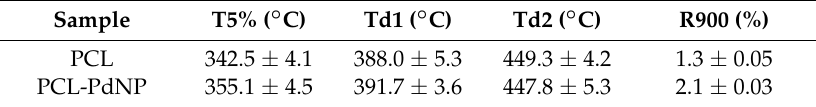
Figure 6. Thermogravimetric analysis (TGA) curves of the electrospun PCL ( left ) and PCL-containing palladium nanoparticles (PdNPs) fibers ( right ). Table 2. Values of thermal stability obtained from the thermogravimetric analysis (TGA) curves of the electrospun PCL and PCL/PdNP electrospun fibers in terms of degradation temperature at 5% of mass loss (T5%), maximum degradation temperature of the two degradation peaks (Td1, Td2), and residual mass at 900 °C (R900).